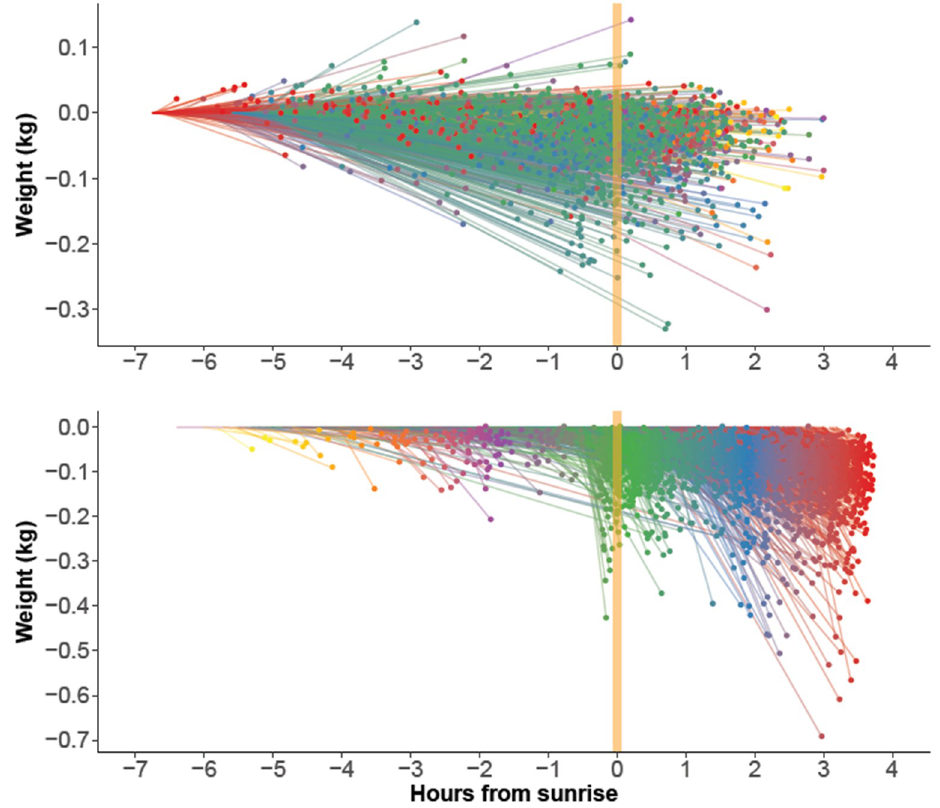
Figure 4. Extracted line segments ( n = 3727) used to estimate nocturnal loss rate (top) and Breakfast Canyon depth (bottom). They correspond to lines D-E and A-B, respectively, in Hambleton’s Graph (Figure 1). All segments were translated to begin at zero weight. Line segments and endpoints were color-coded according to the hour of the segment’s beginning to aid the visualization.